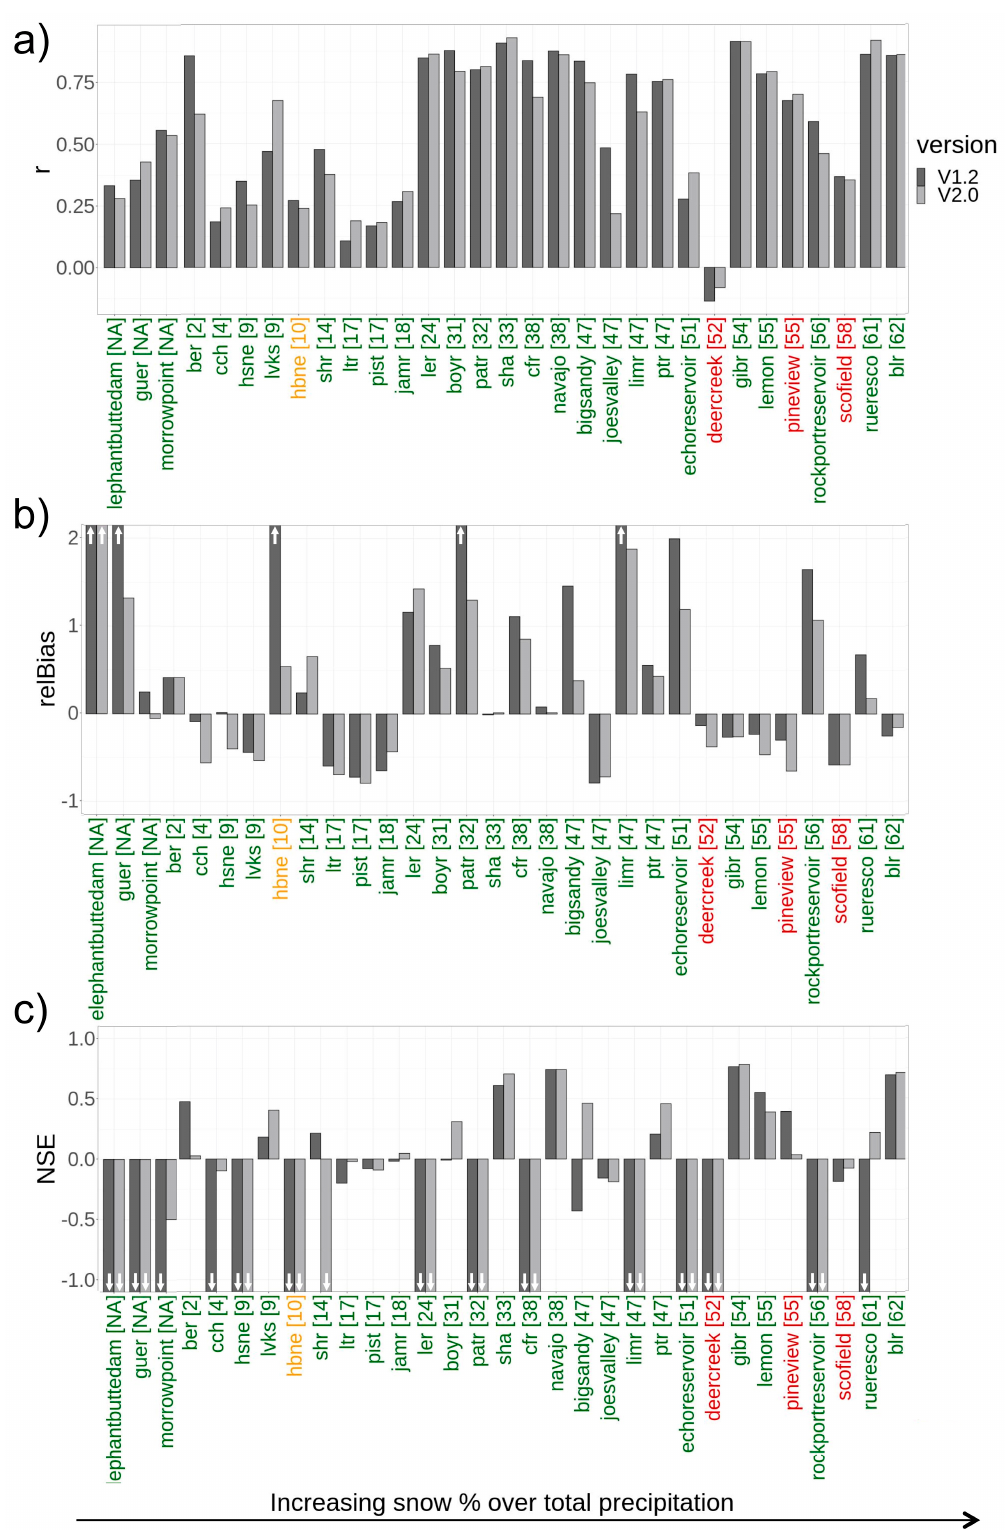
Figure A3. Goodness of fit scores from the NWM v1.2 (dark grey) and NWM v2.0 (light grey) retrospective total inflow evaluation, ordered by increasing snow percentage over total precipitation.from top to bottom: r ( a ) , relBias ( b ) , NSE ( c ) . When the snow percentages are replaced by NAs means that that particular reservoirs did not have any GAGES2 snow percentage information.